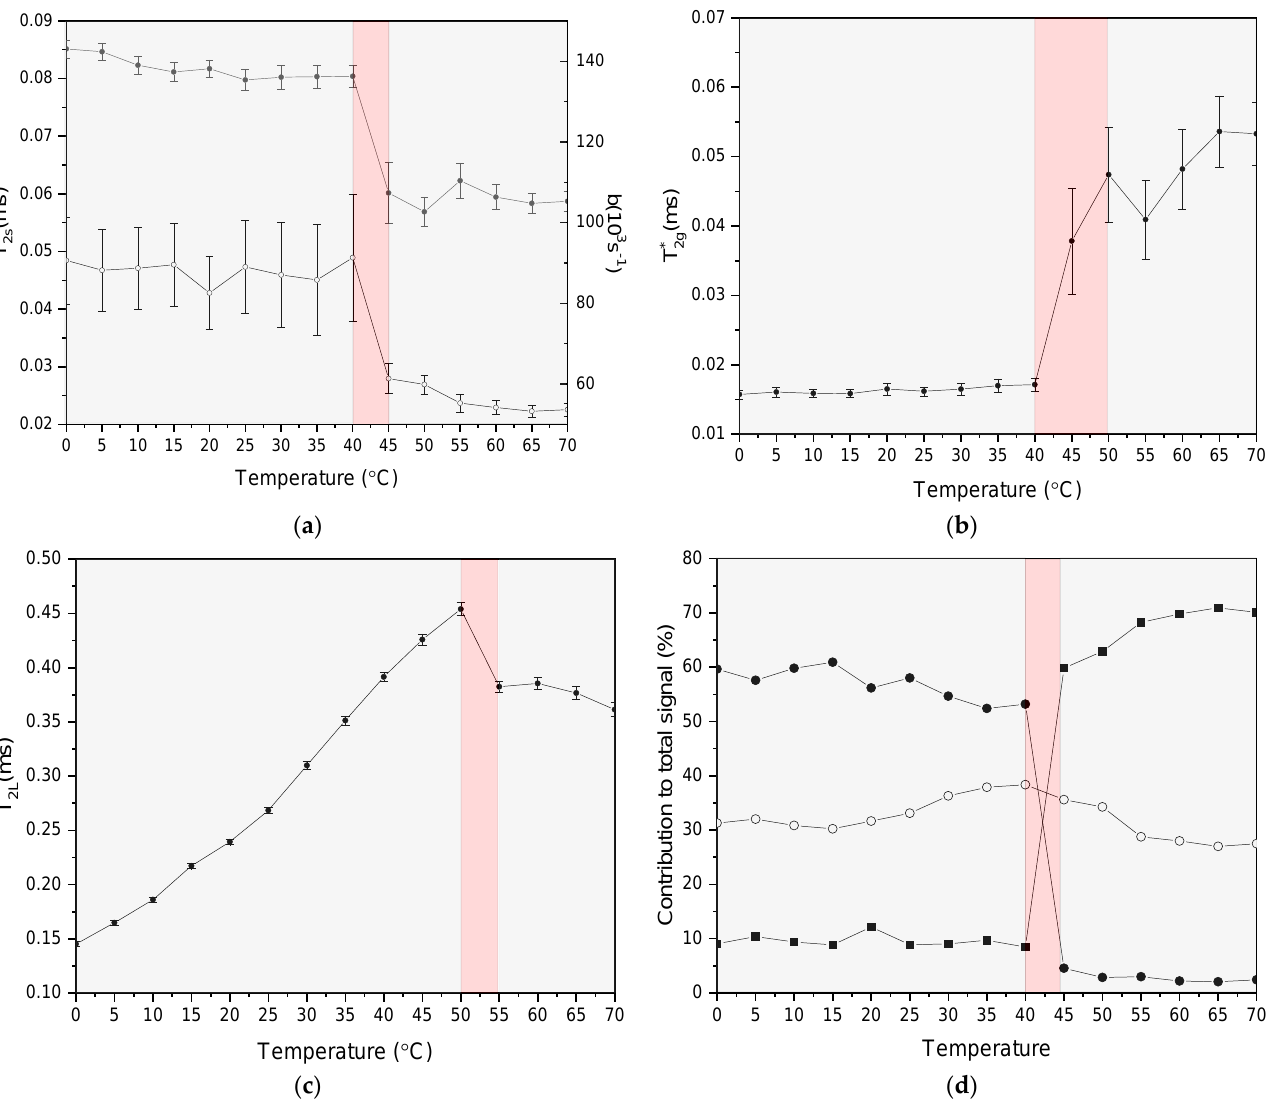
Figure 3. Effects of temperature on NMR relaxation parameters of the model described by Equation (2) for the sample of rice pasta with the water content 0.1069 g/g d.m.: 𝑇 2𝑠∗ and 𝑏 parameter (open and filled circles, respectively) ( a ), 𝑇 2𝑔∗ ( b ), 𝑇 2𝐿∗ ( c ) and the contribution of individual amplitudes 𝑆 𝑠 (solid black squares), 𝑆 𝑔 (solid black circles), and 𝐿 (open circles) to total solid signal (𝑆 𝑠 + 𝑆 𝑔 ) ( d ).